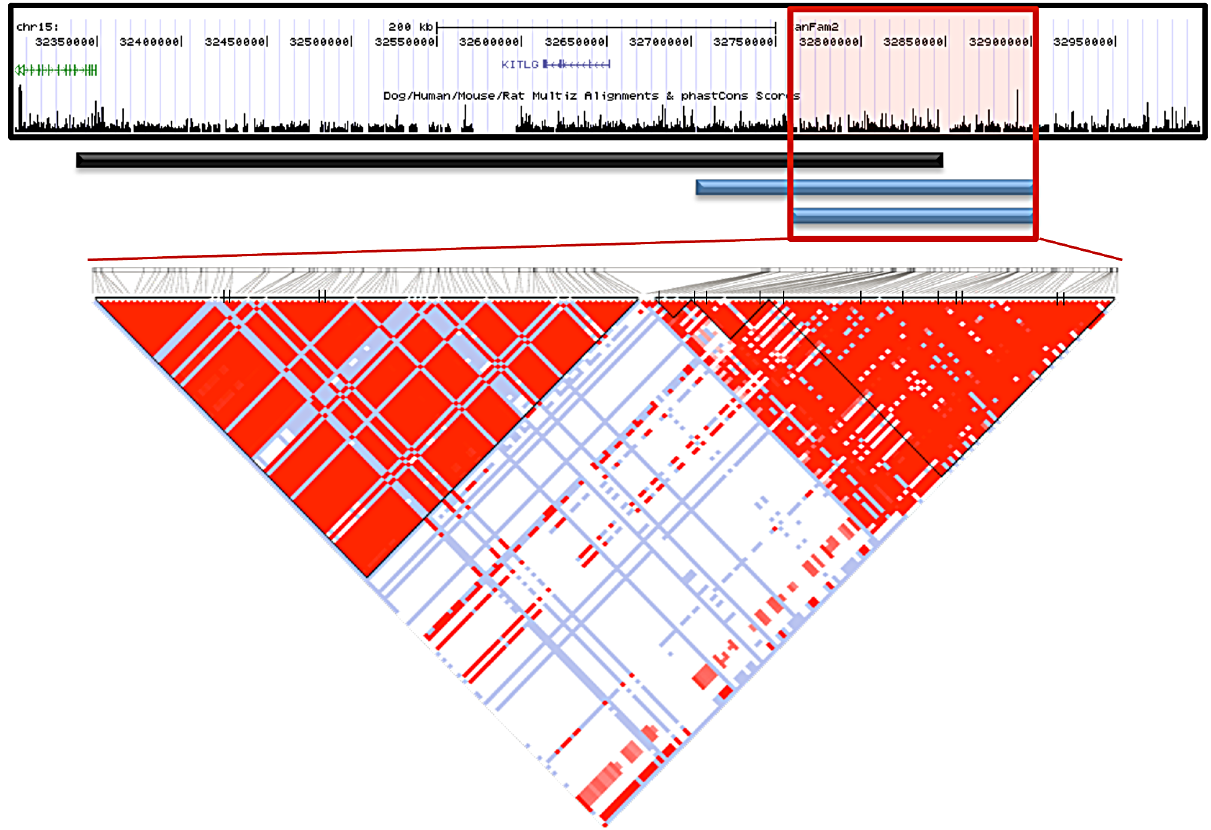
Figure 4. Interbreed haplotype analysis refines the SCCD locus to 144.9 Kb. The black bar represents the STPO one recombination region. The blue bars indicate the results of the interbreed haplotype analyses comparing STPOs with Giant Schnauzers (top blue bar) and Briards (bottom blue bar). The red box outlines the 144.9 Kb consensus region. The triangle plot displays the LD patterns in STPO cases (n=38) and controls (n=30) for the 186 variants within the region. The black vertical lines within the triangle plot indicate the locations of the tagging SNPs or in/dels within each block.